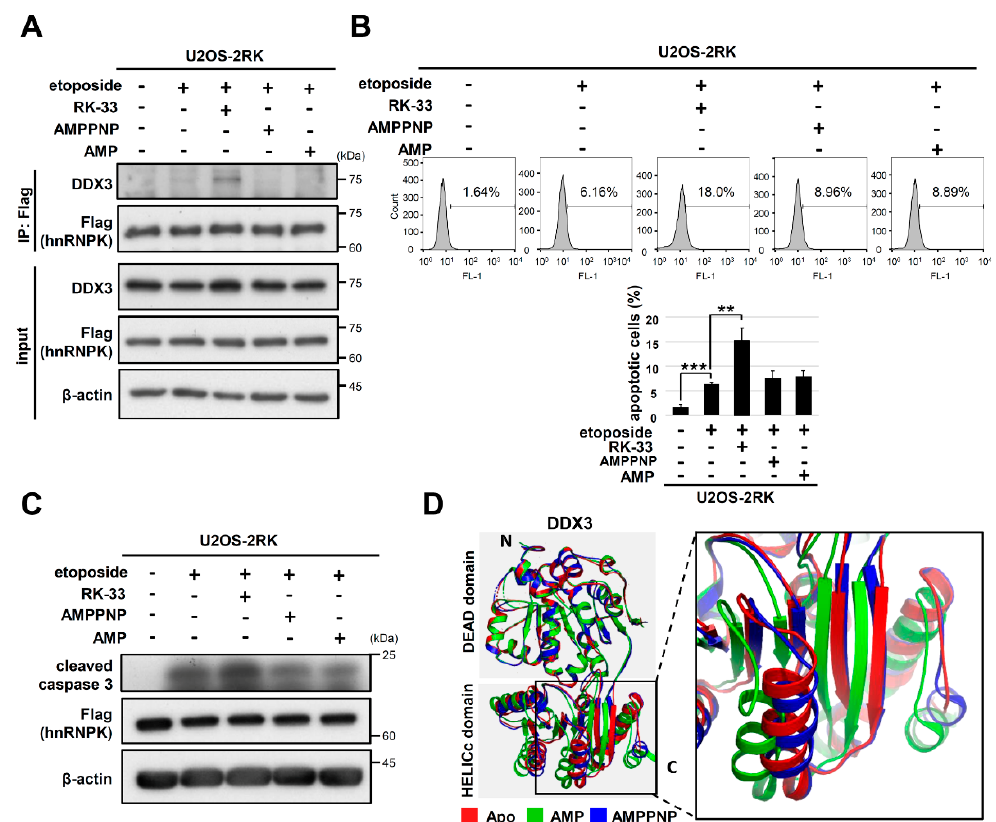
Figure 7. Treatment with AMPPNP and AMP exhibited less enhancement of hnRNPK MD -mediated apoptosis than RK-33 treatment. ( A ) U2OS-2RK cells were treated with etoposide only (50 µ M), etoposide together with RK-33 (5 µ M), AMPPNP (5 µ M), or AMP (5 µ M) for 4 h. Cell lysates were collected to determine the interaction between hnRNPK and DDX3. ( B ) Under the same treatment as described above, cell lysates were collected at 12 h and were analyzed by TUNEL assay to determine the degree of apoptosis using FACS (top). Quantitation of apoptotic cells in the TUNEL assay is shown (bottom). ( C ) Under the same treatment as described above, cell lysates were collected at 12 h. Cell lysates were collected and analyzed for the expression levels of active caspase-3. ( D ) Structural comparison among the apo form of hDDX3 (PDB: 5e7i) and hDDX3 cocrystallized with either AMPPNP (PDB: 5e7j) or AMP (PDB: 5e7m) was conducted. The zoomed-in square indicates the major difference in the C-terminal conformation between AMPPNP-bound hDDX3 and AMP-bound hDDX3. ** as p < 0.01, *** as p < 0.001.